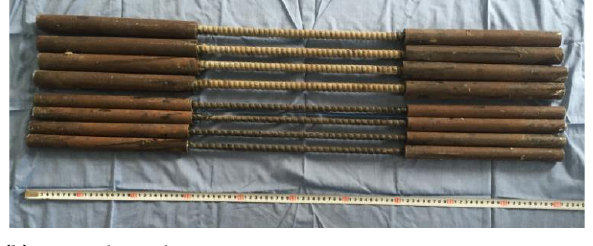
Figure 3: Tensile specimens of GFRP bars